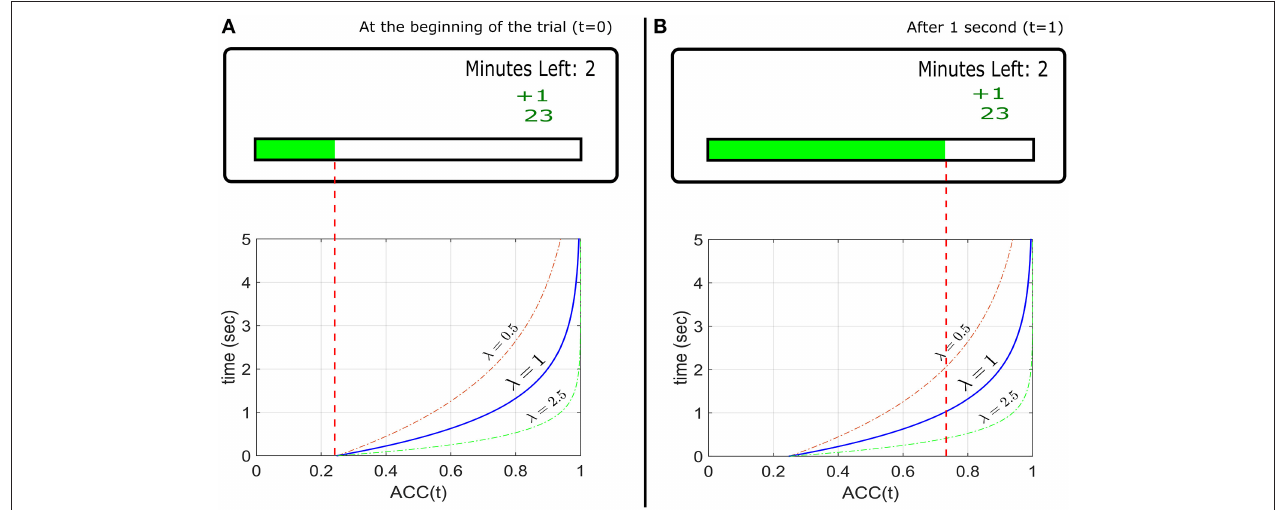
FIGURE 1 | Top Panels: Example of the experimental design used to implement the EXACT paradigm, showing how the gauge represents the probability at time t assuming a starting point at 25% during a hypothetical trial. The small green (point won/lost). The number below represents the total current score for that condition. The “minutes left” refers to the minutes left for that condition. (A) Top: the screen as seen by the participant at the beginning of the trial ( t representing the probability of getting a reward with time. The gauge on the top panels is only referred to the function with λ how the accuracy would change in time for different λ . For example, with λ completely